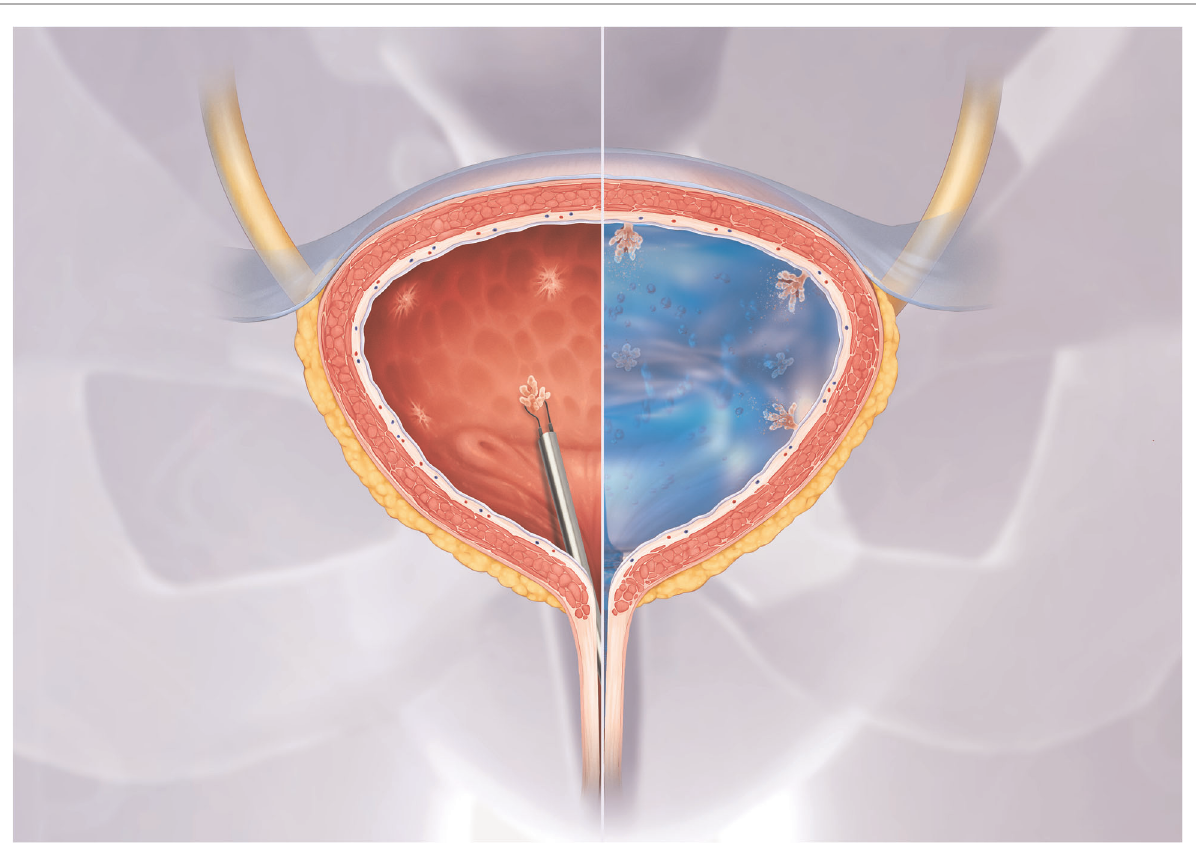
FIGURE 4 UGN-102 hydrogel for intravesical mitomycin C instillation. Figure supplied by UroGen. UGN-102 is a mitomycin hydrogel. When instilled into the bladder UGN-102 turns from a liquid into a gel substance, which increases drug retention time for up to six